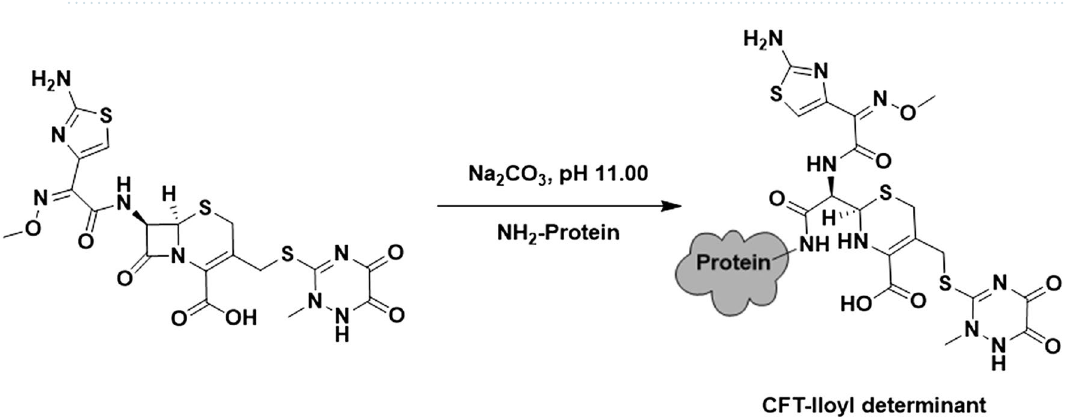
Figure 2. Conjugation of protein CFT -lloyl determinant. https ://www.micro soft.com/es-es/micro soft-365/ power point